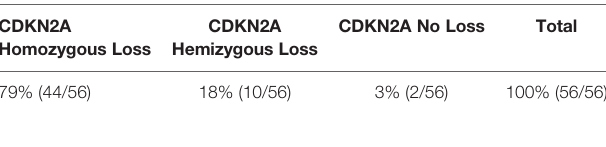
TABLE 2 | Homozygous, hemizygous and no loss of CDKN2A detected by fl uorescence in situ hybridization (FISH) in malignant pleural mesothelioma (MPM) cases.